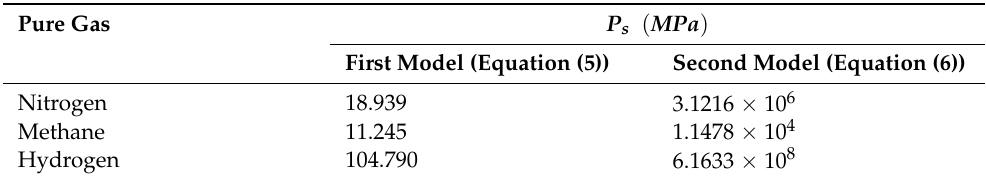
Table 2. Pseudo-vapour pressure at T = 298 K .